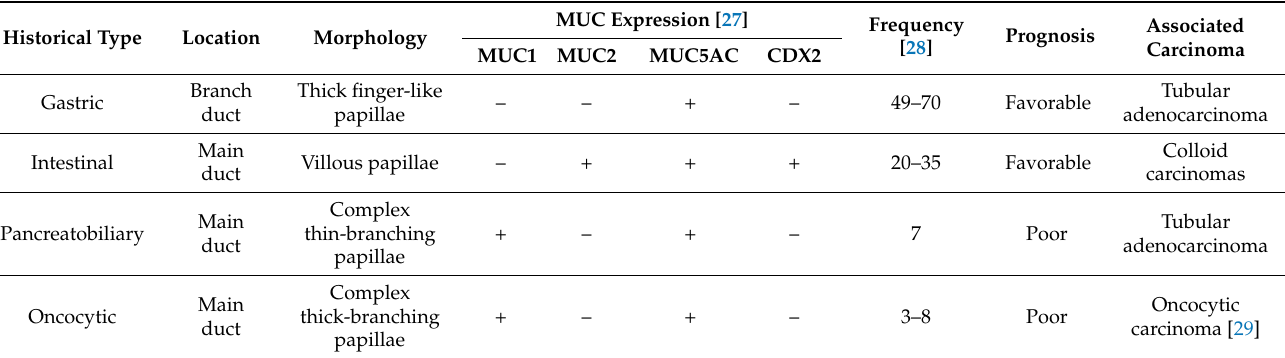
Table 1. Description of four historical types of